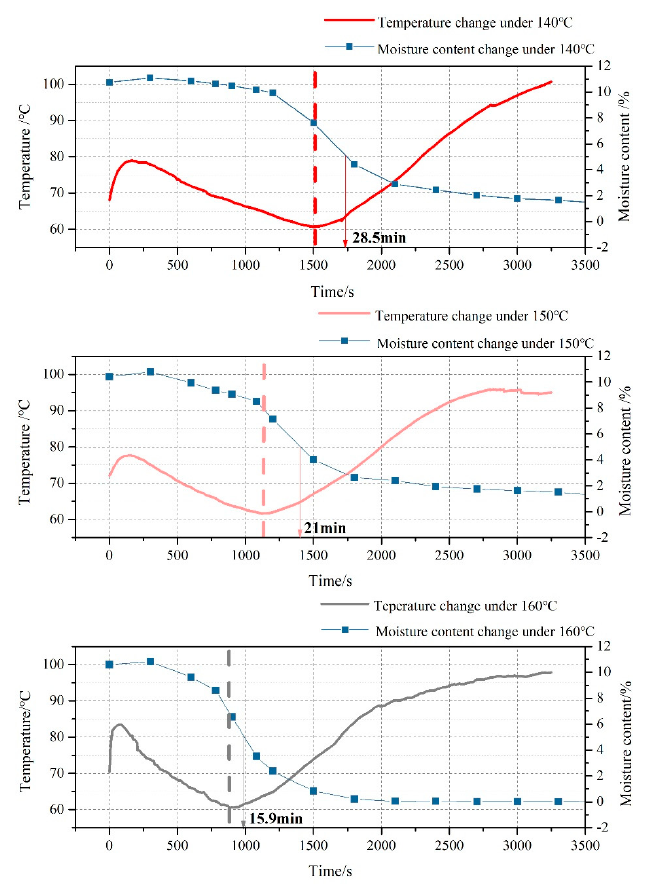
Figure 6. Surface temperature and moisture content change of 2 cm thick coal under di ff erent heating temperature in thin-layer drying